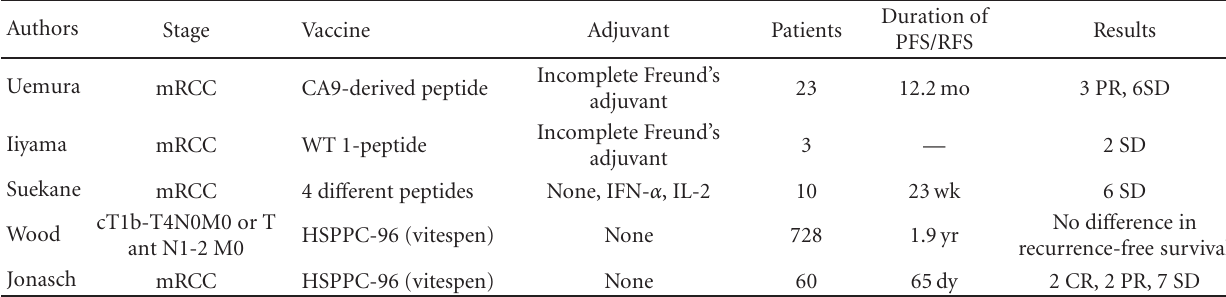
Table 2: Peptide-based